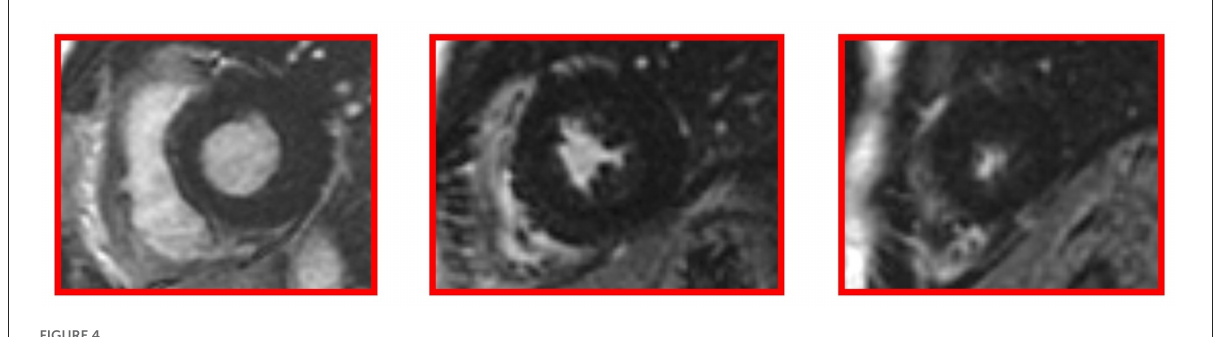
FIGURE4 Late gadolinium enhancement (LGE) images without hyperintense myocardial areas at the left